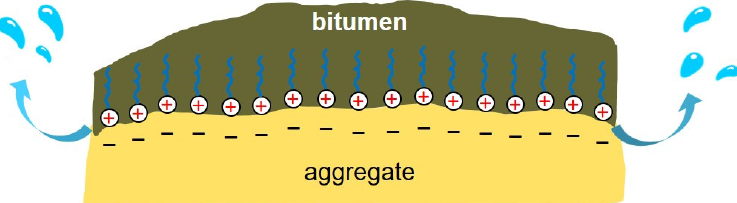
Figure 2. Active adhesion is ensured by the favorable orientation of positively charged surface ‐ active molecules by decreasing the contact angle between bitumen and the negatively charged aggregate interface, allowing the water displacement, and maximizing the surface coating.